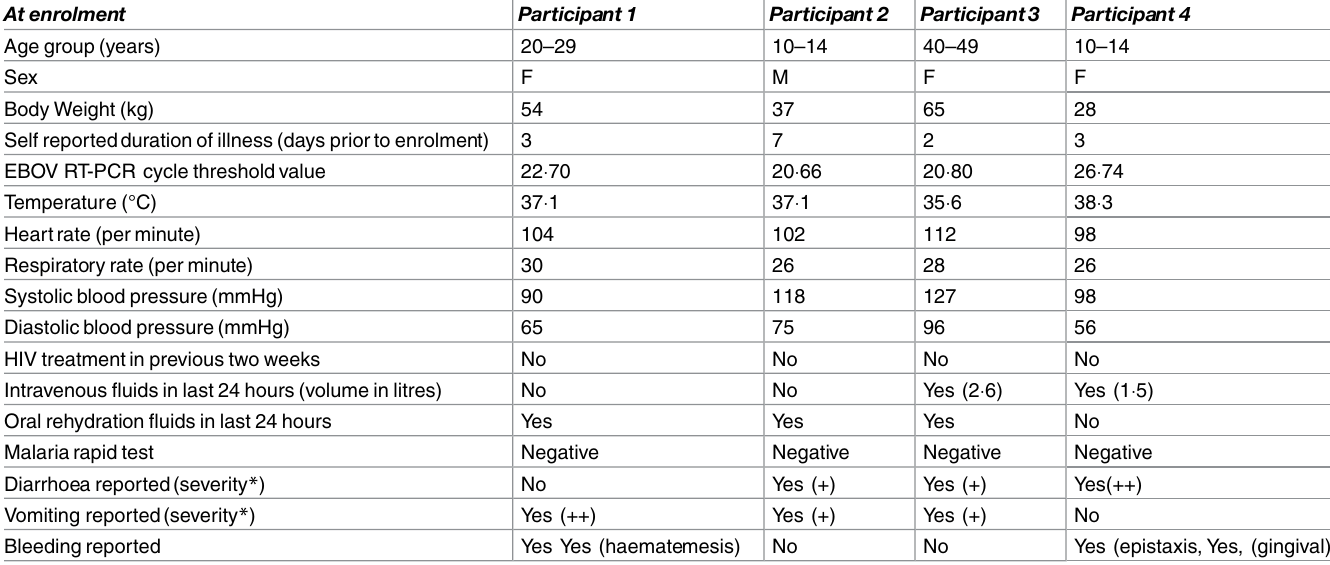
Table 1. Demographic and clinicalfeaturesat